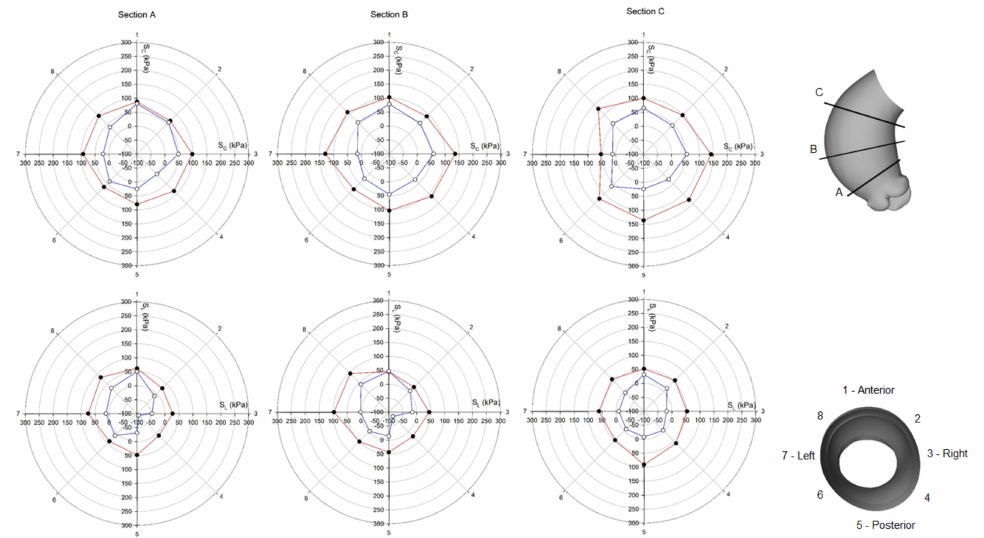
Figure 9. Polar plot of stress distribution along three different sections for healthy LHHM at late diastole for both the inner aortic wall surface (red lines) and the outer aortic wall surface (blue